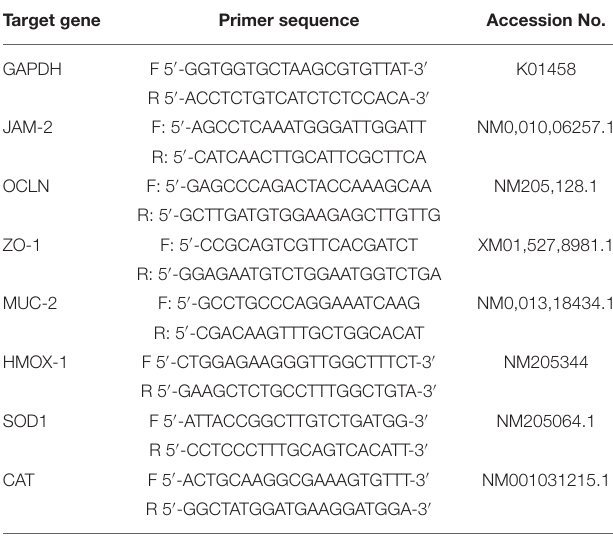
TABLE 2 | Quantitative real-time PCR oligonucleotide primer sequences. Target gene